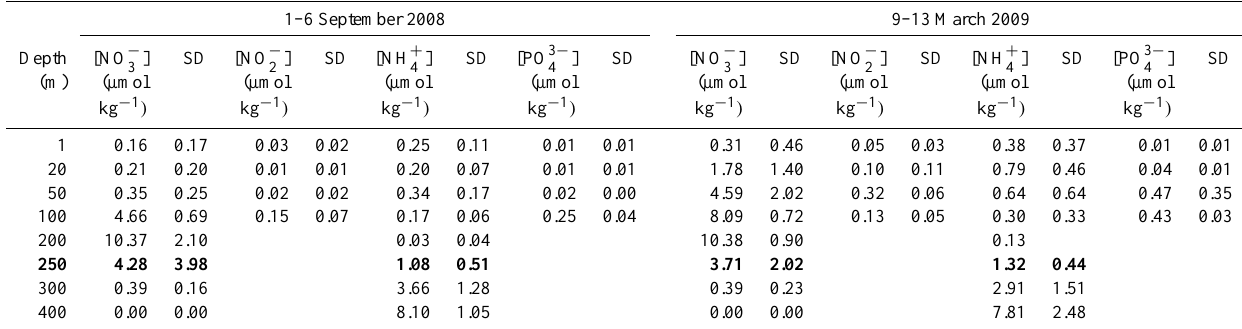
Table 2. Average nutrient concentrations from stations sampled for N xs Cariaco Basin. Values near the oxic–anoxic interface are shown in bold captions.